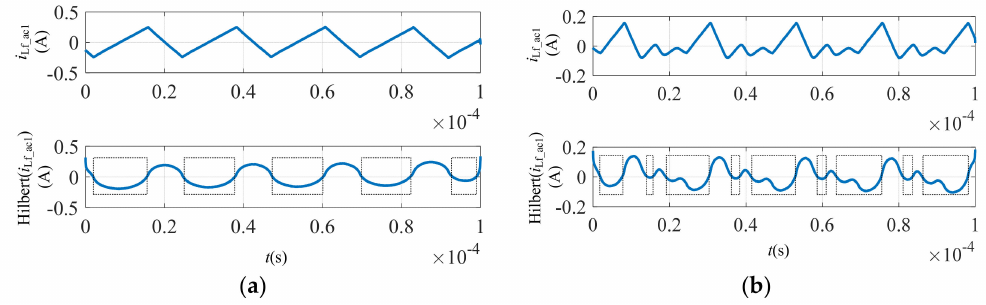
Figure 9. The de-noised ac component of the inductor current and its Hilbert transform: ( a ) CCM; ( b ) DCM. Table 4. ESR Experimental Results of Buck Converter by Method 1 after